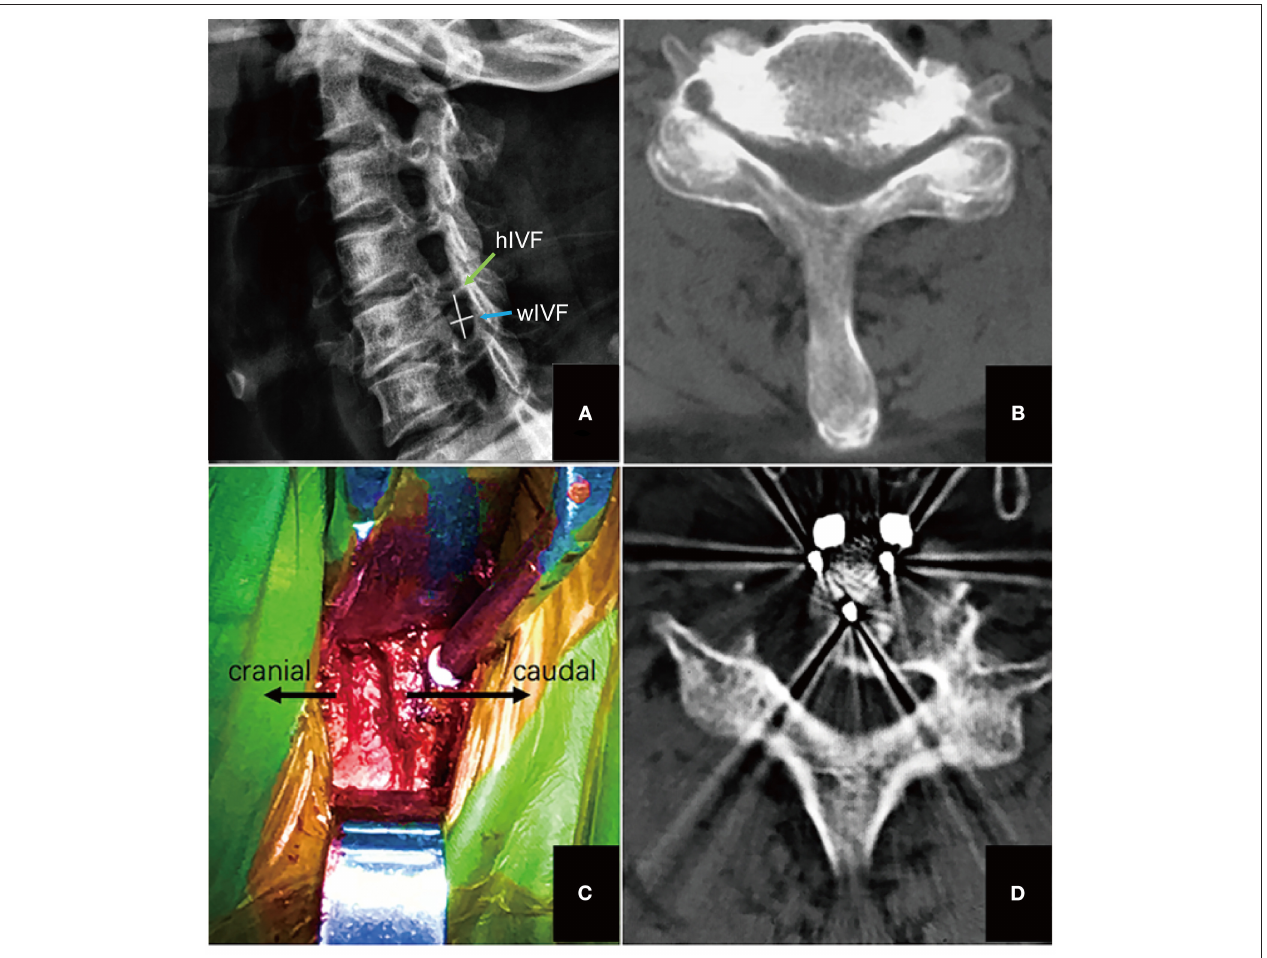
FIGURE 1 | The process of performing UPR. (A) The width of intervertebral foramen (IVF) was measured by calculating the distance from the anterior medial point to the posterior medial point of the foramen (the transverse line) as width of IVF (wIVF), the height of IVF was measured by calculating the distance from the superior medial point to the inferior medial point of the foramen (the vertical line); (B) CT scan was used to confirm the hypertrophied uncinated process, meanwhile evaluating the anatomical relationship between vertebral artery and uncinated process; (C) the intraoperative view of surgical level after uncinated process was resected; (D) post-operative CT scan confirmed decompression of uncinated process